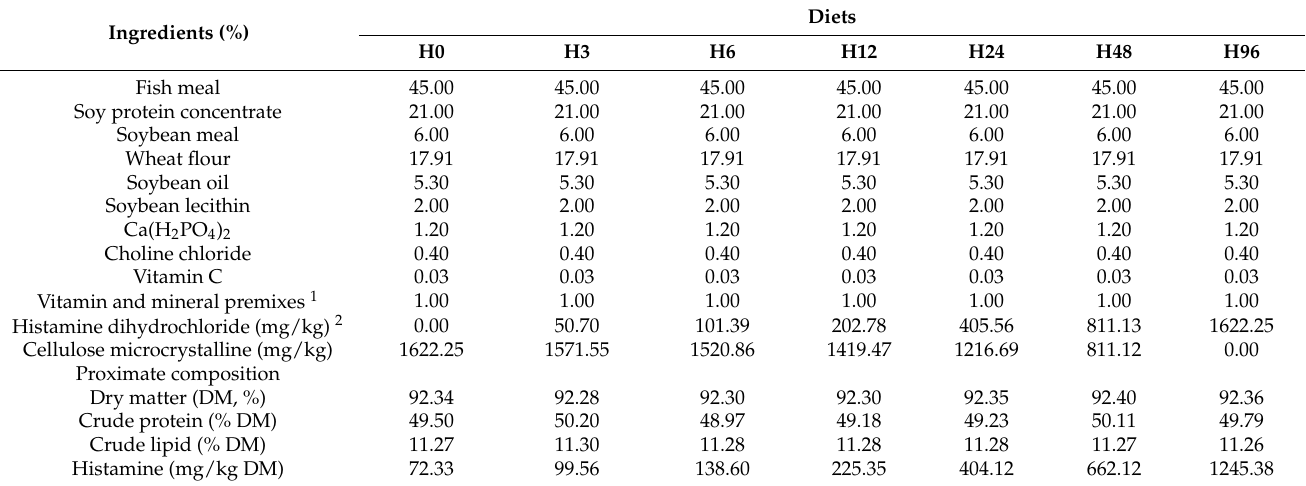
Table 1. Ingredients and chemical composition of the experimental diets (% dry